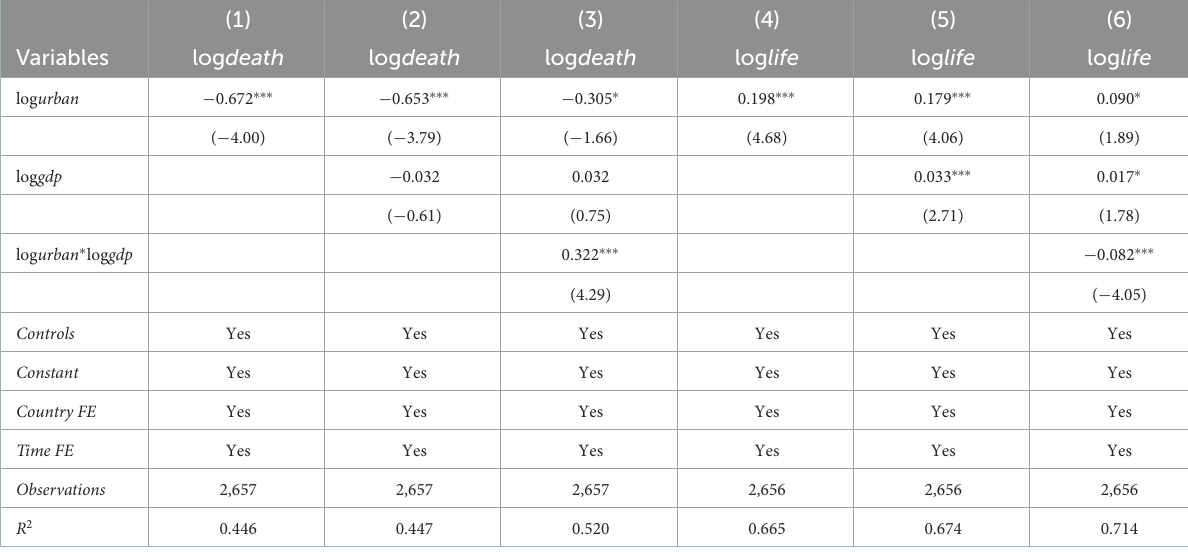
TABLE 10 Test results of potential channel mechanism (crude death rate and total life expectancy).